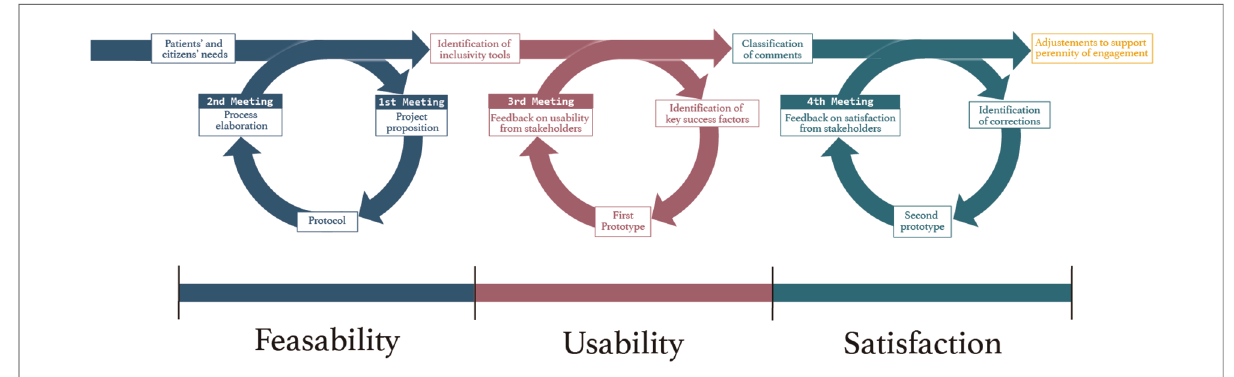
FIGURE 1 The COMVIP project Co-creation